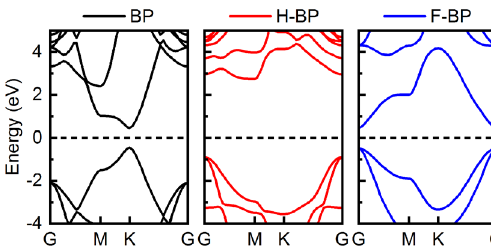
Figure 3. Electronic band structure for BP, H-BP and F-BP.